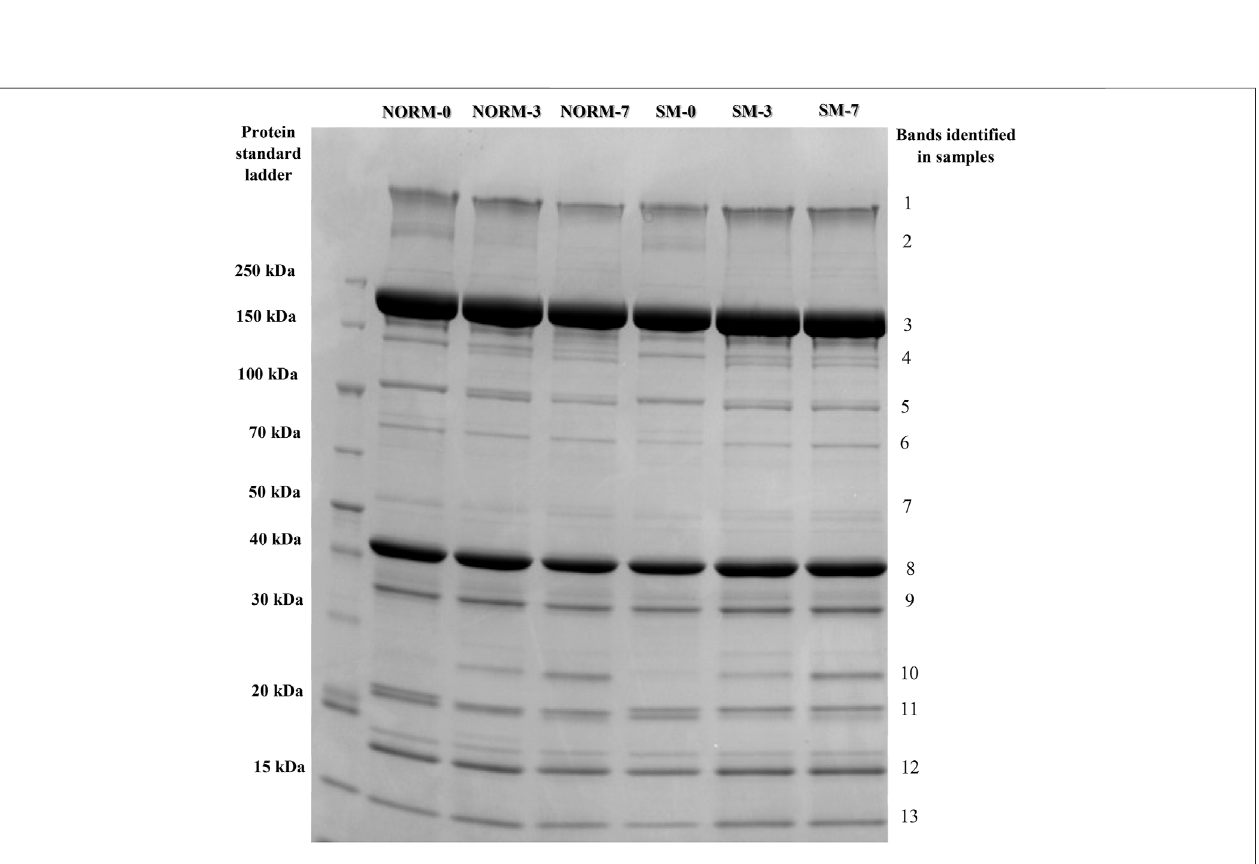
Frontiers in Physiology |